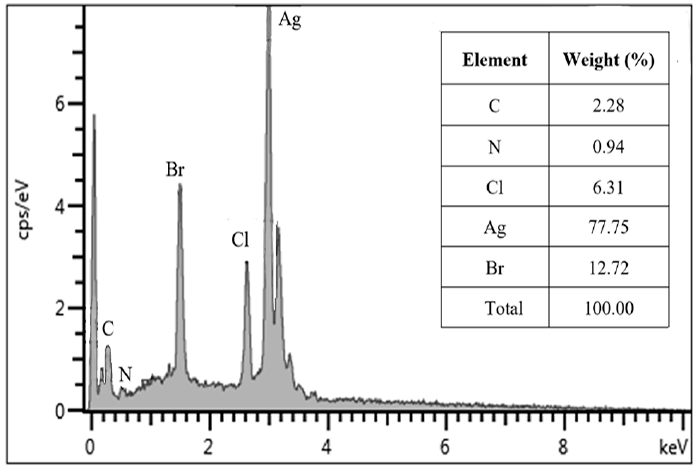
Figure 6. The elemental analysis of Br-doped PANI.